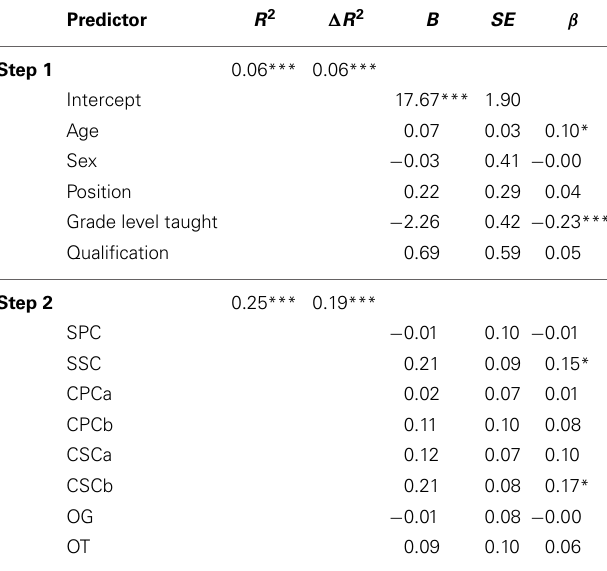
Table 6 | Summary of hierarchical multiple regression analysis predicting satisfaction in teaching life from demographic variables and control processes.